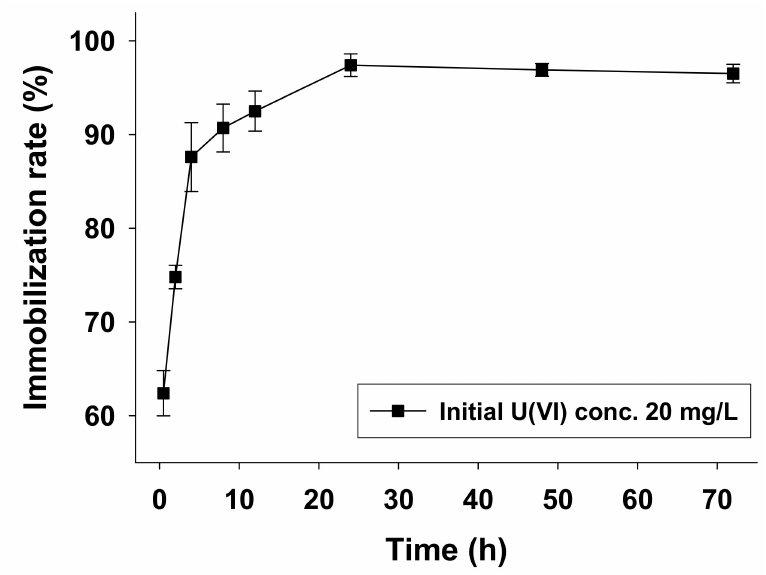
Figure 2. The effect of time on the uptake of U(VI) by Parachlorella sp. AA1 (C init 20 mg/L, pH init